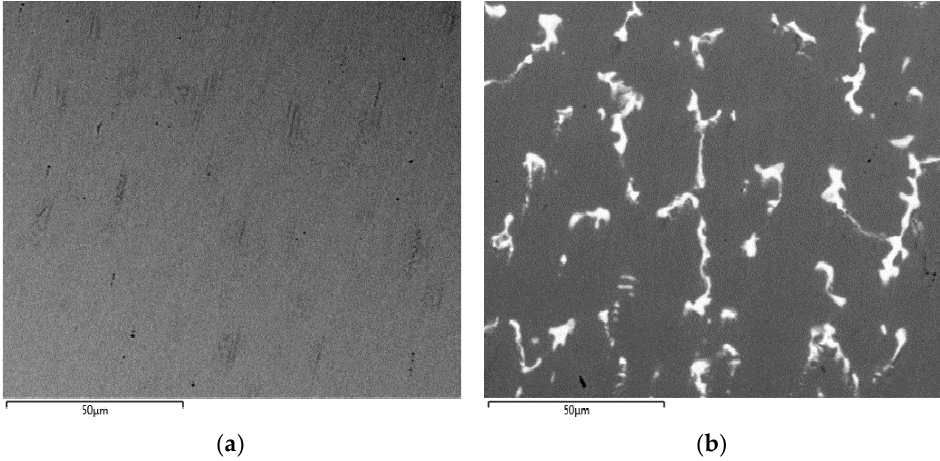
Figure 1. Backscattered electron micrographs of as-cast ( a ) Ti 16 V 60 Cr 24 alloy; ( b ) Ti 16 V 60 Cr 24 + 4 wt.% Zr alloy.